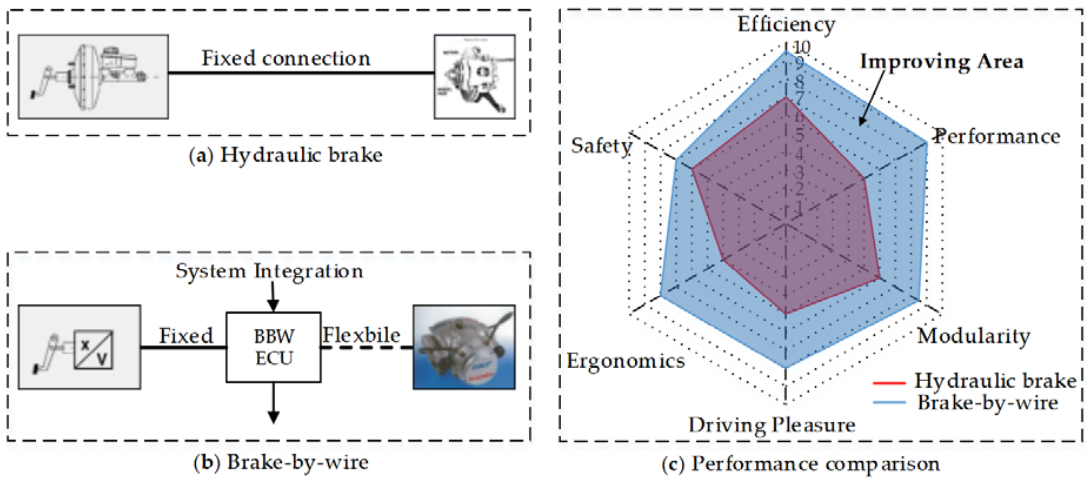
Figure 2. The structure and performance of hydraulic brake and brake-by-wire (BBW).